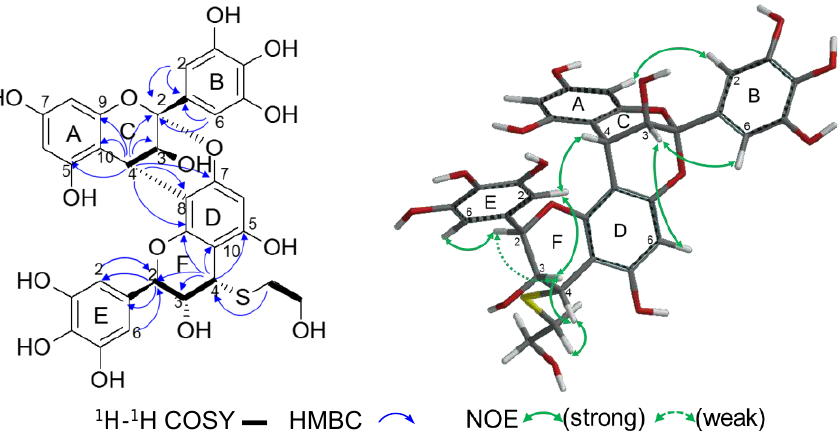
Figure 10. 1 H- 1 H COSY, HMBC, and NOESY correlations of 7 . Figure 9. Calculated (a–d) and experimental (e) ECD spectra of prodelphinidin trimer thioether ( 3 ).